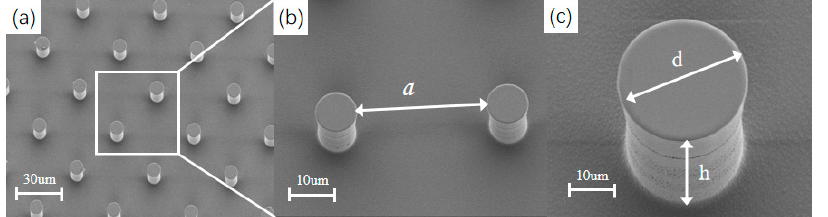
Figure 5. The SEM pictures of Si rough surfaces. ( a ) the whole picture of the Si rough surface. ( b ) the periodic spacing a of the circular microstructures. ( c ) the diameter d and the height h of the circular microstructures.